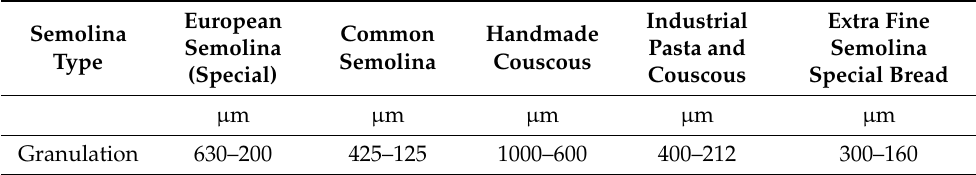
Table 9. Specifications related to particle size